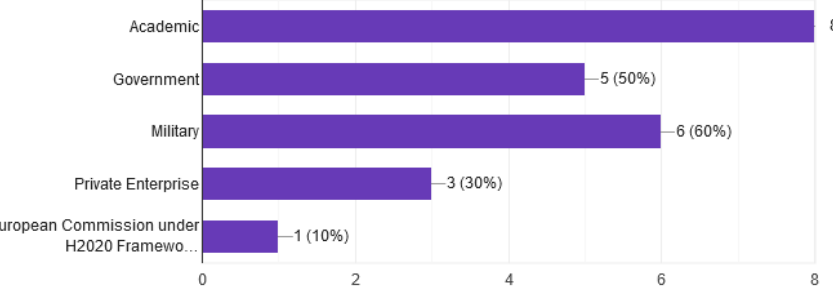
Figure 2. Sectors of the Cyber Range.